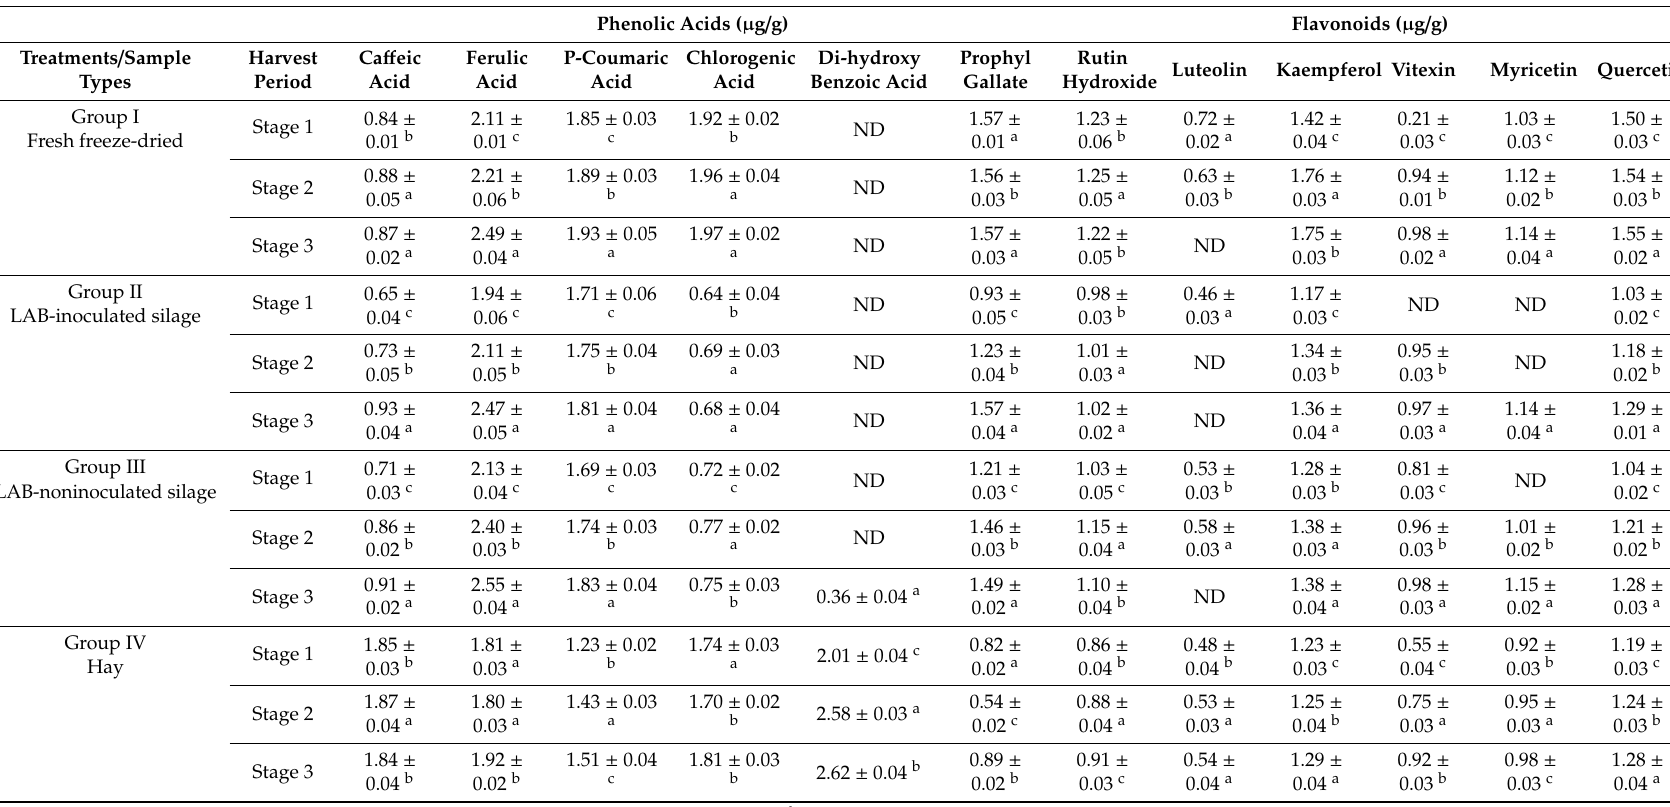
Table 3. Quantification of phenolic acids and flavonoids from WCR silage, hay, and fresh freeze-dried extract at di ff erent stages of maturity ( µ g /